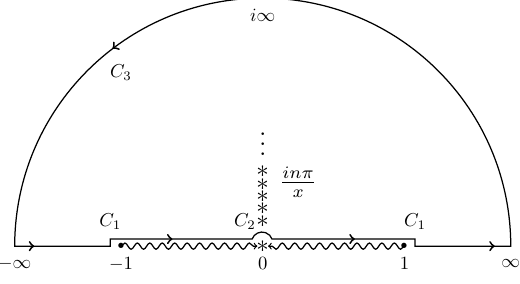
Figure 4. Integration contour γ for the integral I